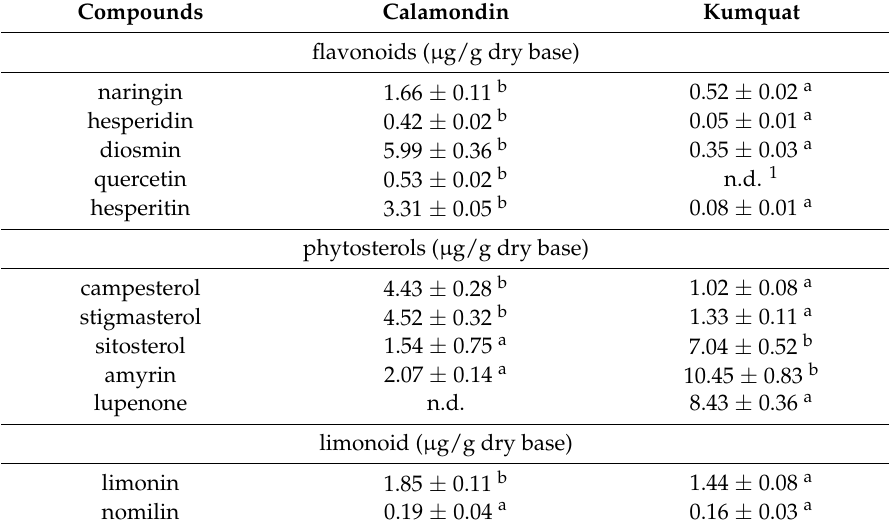
Table 2. Flavonoids, phytosterols and limonoid composition of small-size